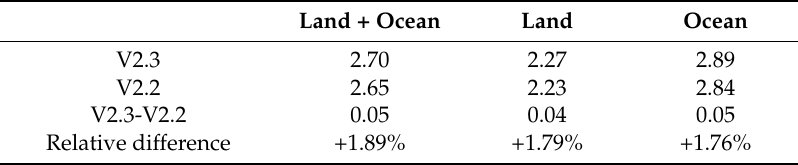
Table 3. Global mean precipitation (P, mm day − 1 ) from GPCP V2.3 and V2.2 and their differences from 2009–2013 (both Special Sensor Microwave Imager (SSMI) to Special Sensor Microwave Imager/Sounder (SSMIS) and TOVS to AIRS transitions are